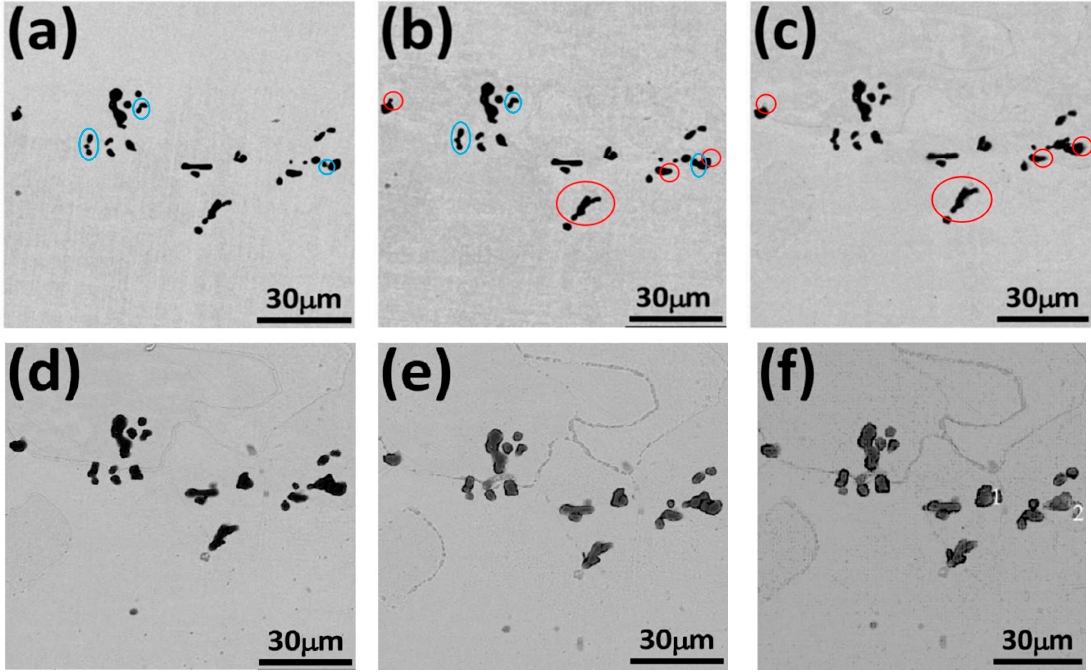
Figure 3. Morphology observation of clustered Al 2 O 3 inclusions: ( a ) 0 s; ( b ) 15 s; ( c ) 35 s; ( d ) 65 s; ( e ) 105 s; and ( f ) 155 s.